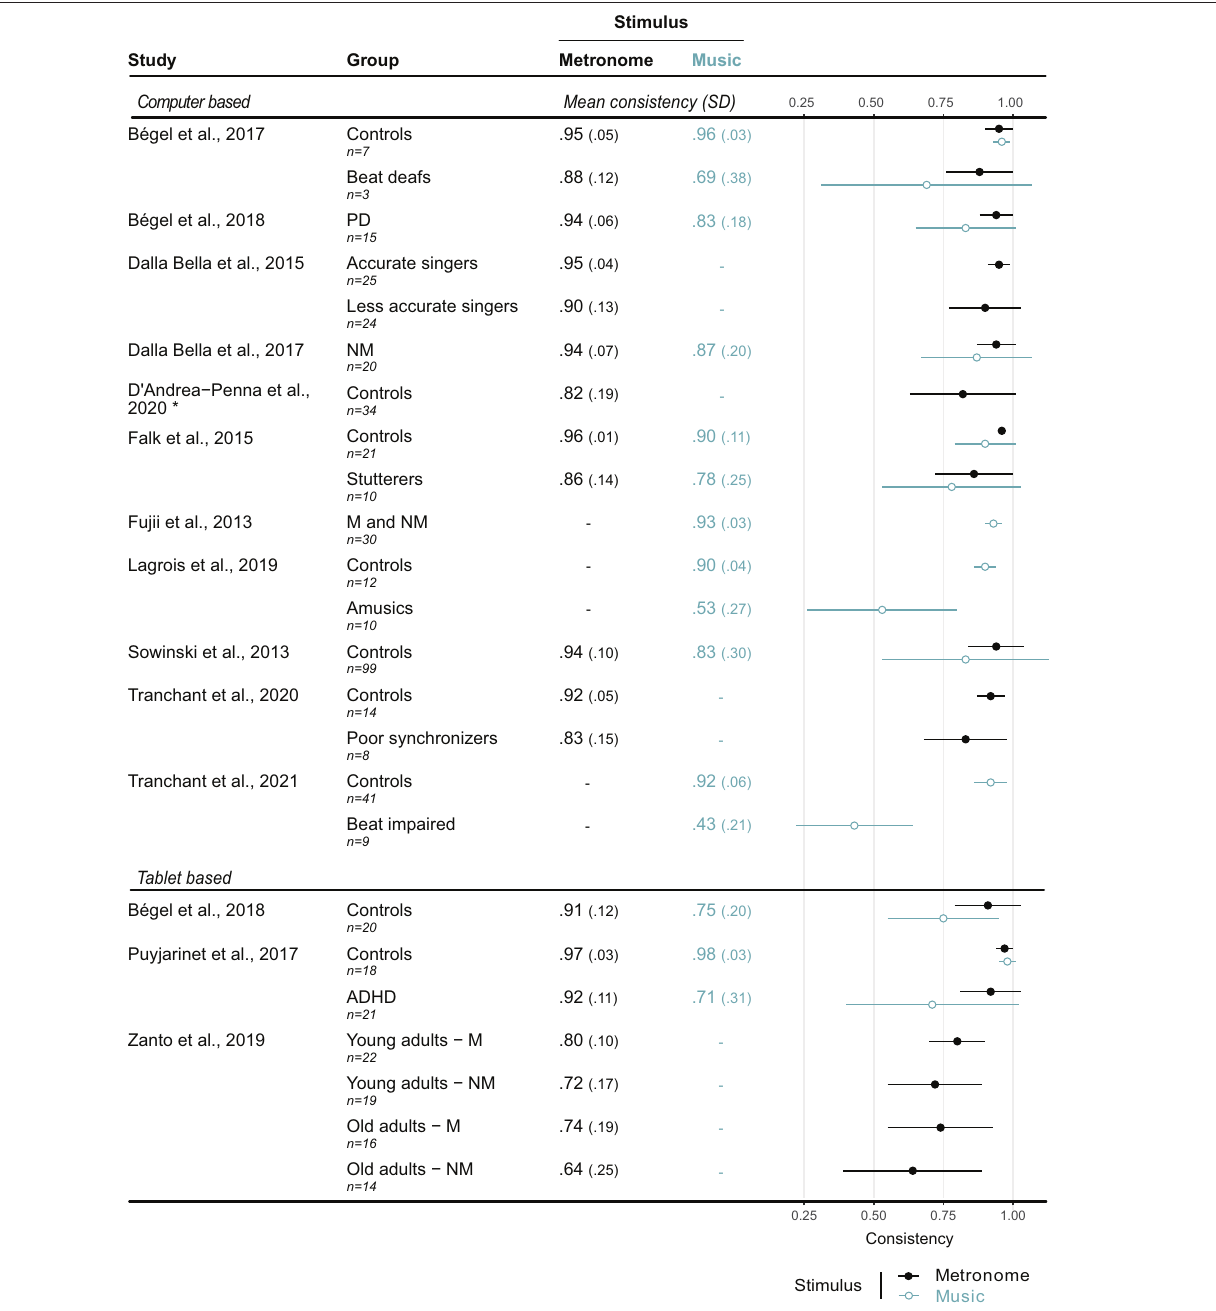
FIGURE 1 | Comparison of synchronization consistency obtained during AMS tasks using a metronome or music. Synchronization consistency, a common measure of AMS, is a value from 0 to 1 (0 = lack of synchronization, high variability; 1 = perfect phase-locking between the taps and the beat, no variability). The results of AMS with a metronome are the mean of three different tempi that are comparable across studies (slow–around 450ms, medium–around 600ms, and fast–around 750ms). The music stimuli were excerpts with an inter-beat interval around 600ms. The dots on the plot represent the mean consistency, and the bars, the standard deviation. NM, non-musician; M, musician; ADHD, attention deficit disorder with or without hyperactivity; PD, Parkinson’s disease; PS, poor synchronizers. *The task used in this study involved tapping to stimuli with 15% randomly omitted beats. Synchronization to these stimuli, less predictable than a standard metronome, may have yielded lower consistency values than in most of the other